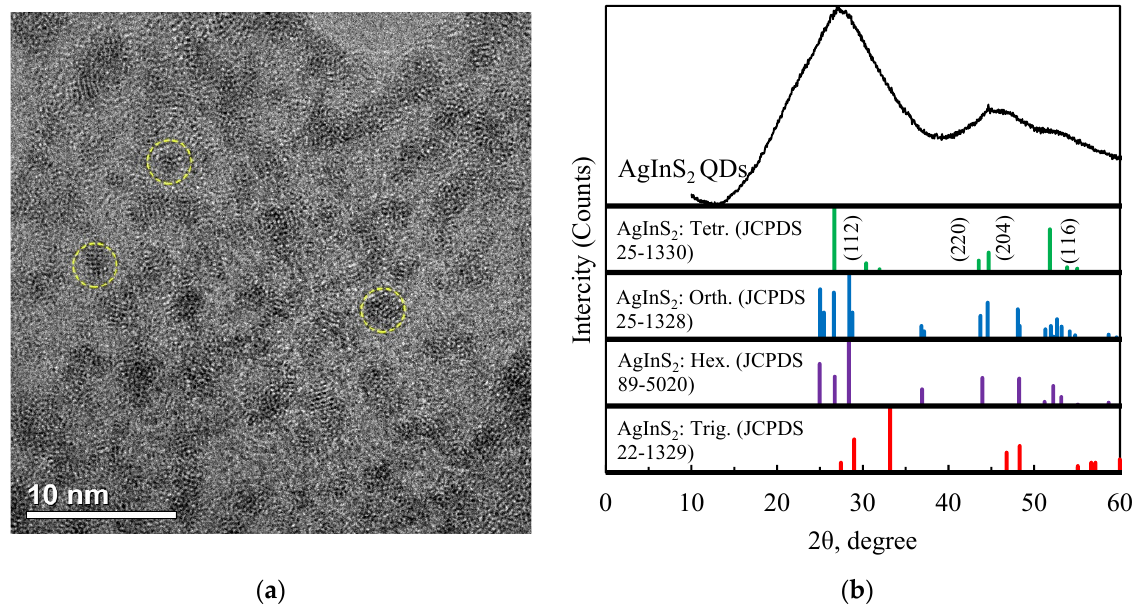
Figure 1. ( a ) TEM image of colloidal AgInS 2 QDs; ( b ) XRD patterns of AgInS 2 QDs.